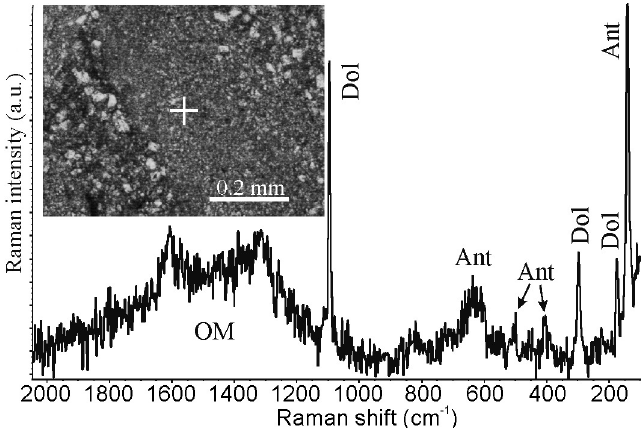
Figure 10. Thin section photographs of: ( A ) fine grained and semi-translucent, red-brownish, or greyish background with larger crystals of dolomite and rarely quartz (white spots). There is a fragment composed of only very fine grained semi-translucent dolomitic, dark mass in the centre of the image. ( B ) Euhedral, larger dolomite crystals (Dol—dolomite). ( C ) Anhedral, large quartz crystals (Qz—quartz). ( D ) The light colour, rounded dolomitic fragment and halite vein (Hl—halite). ( E ) The dark coloured rounded fragment. ( F ) Irregular halite veins (Hl—halite).